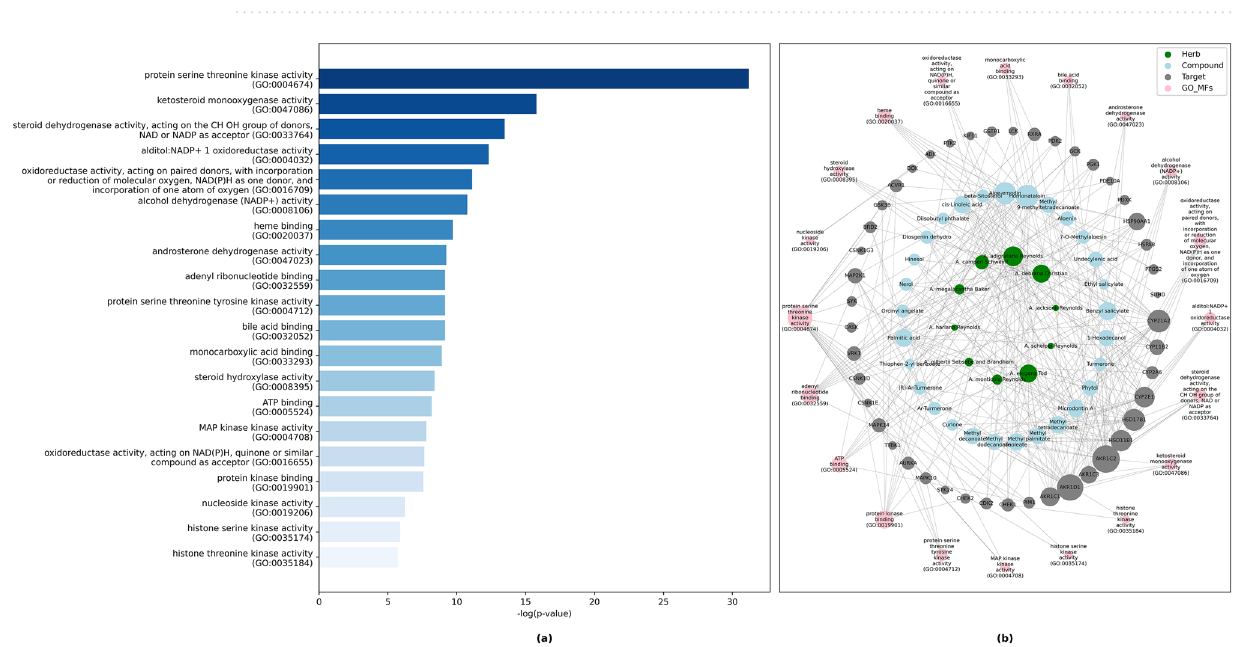
Figure 2. (a) Bar graph of KEGG analysis for top 20 enriched biological processes. (b) Phytochemical-target- biological process network constructed by python NetworkX library illustrated pathways and their associated genes (Adjusted P ≤ 0.05).